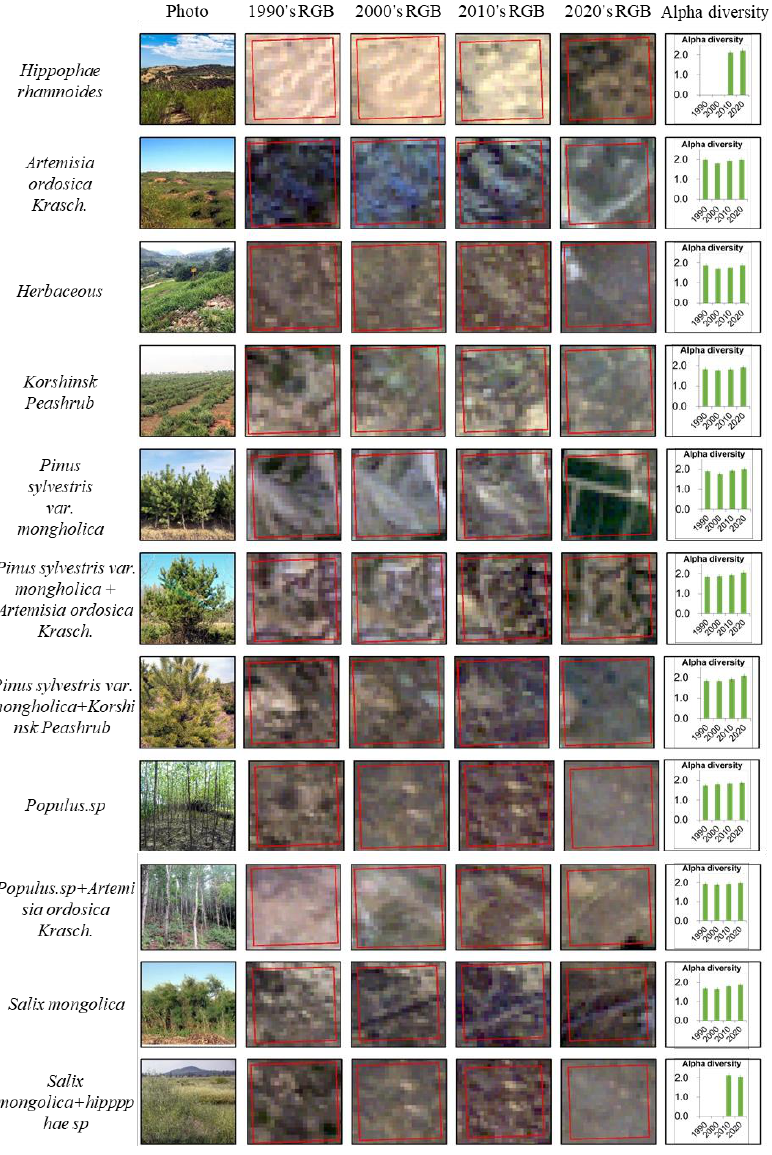
Figure 8. Changes in alpha diversity among different plant communities. No data were available for the Hippophae rhamnoides and Salix mongolica + Hippophae communities in 1990 and 2000 because they were introduced into the study area during vegetation restoration efforts after 2000.